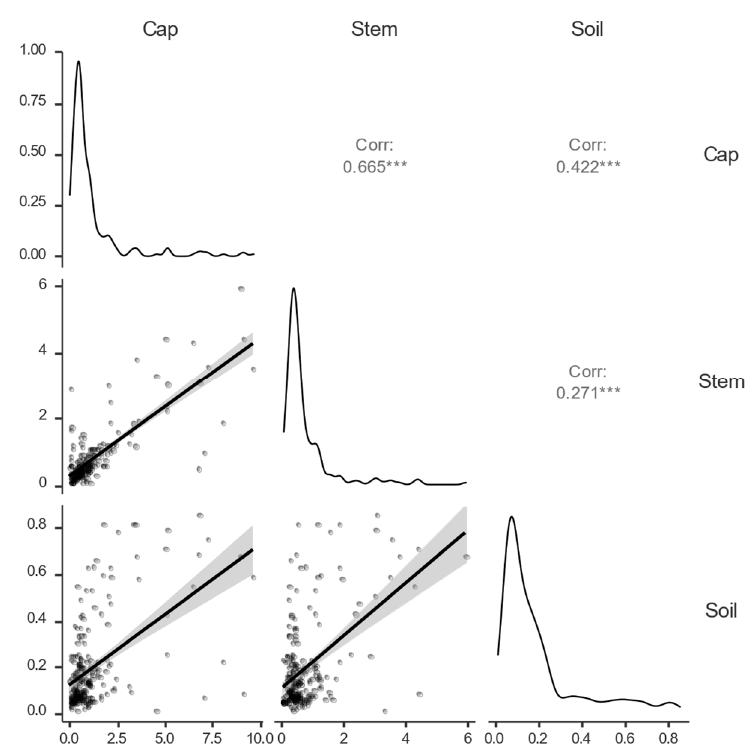
Figure 5. Spearman’s correlation matrix between the soil/substrate and the fruiting body parts (cap, stem). (*** p < 0.001).